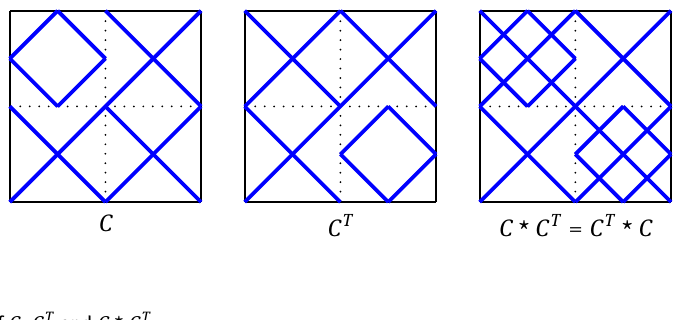
Figure 1: The supports of C , C T and C * C